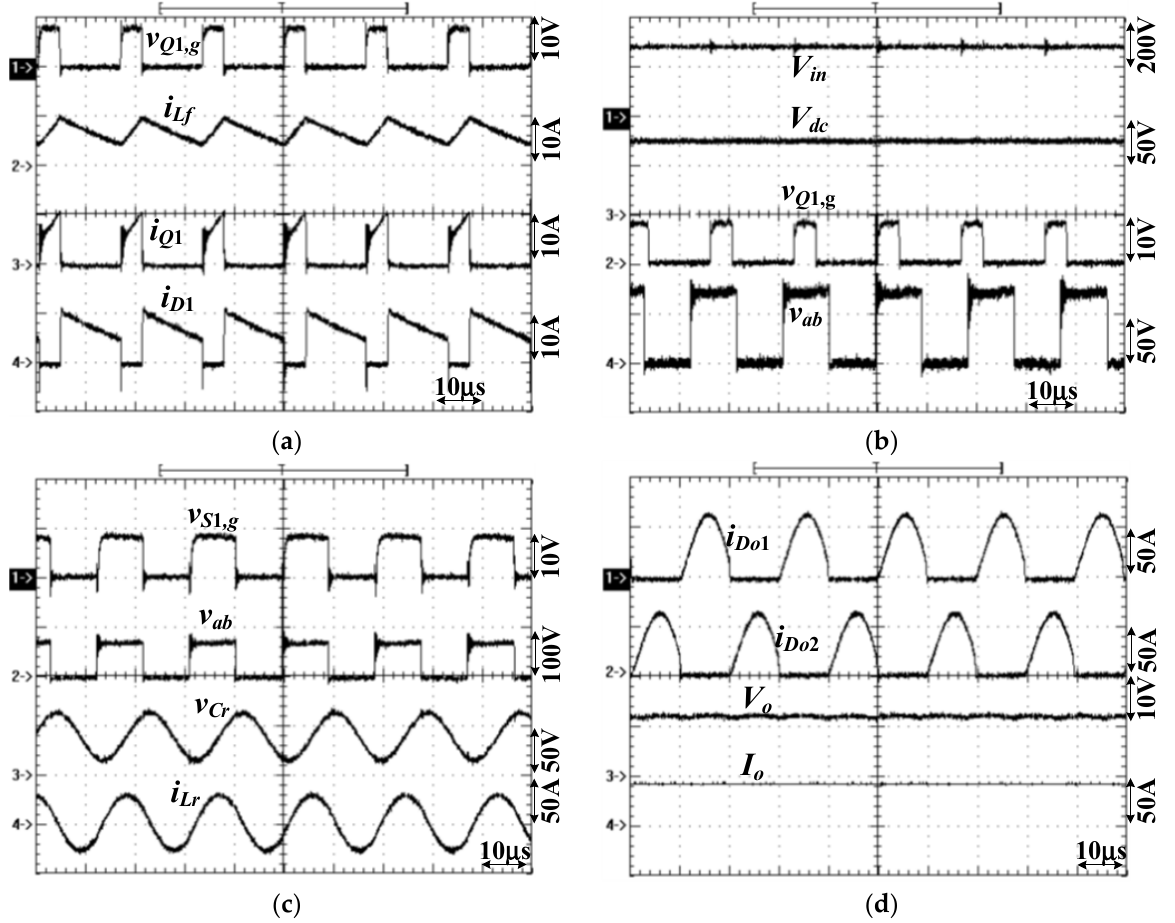
Figure 9. Measured results at V in = 288 V and P o = 500 W ( a ) v Q 1, g , i Lf , i Q 1 and i D 1 ( b ) V in , V dc , v Q 1,g and v ab ( c ) v S 1, g , v ab , v Cr and i Lr ( d ) i Do 1 , i Do 2 , V o and I o .